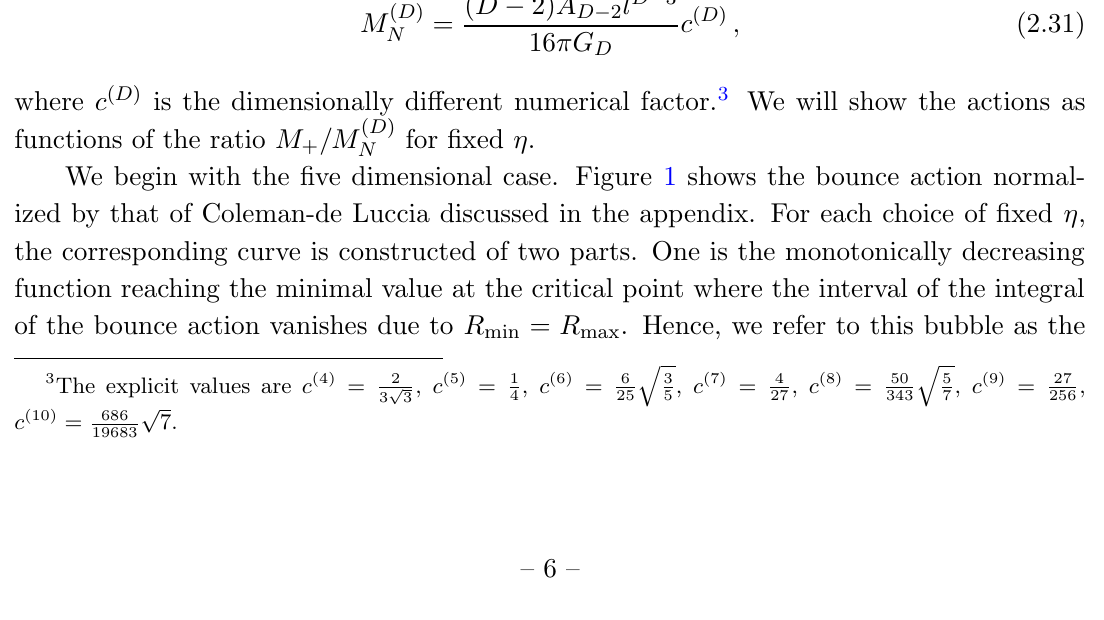
in (cid:12)ve dimensions.